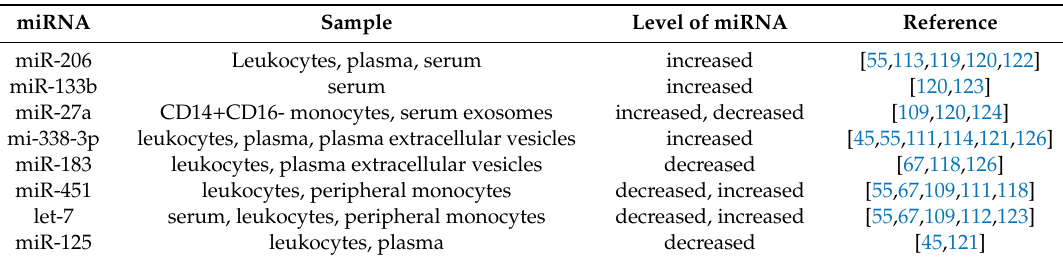
Table 1. The most promising potential circulating miRNA